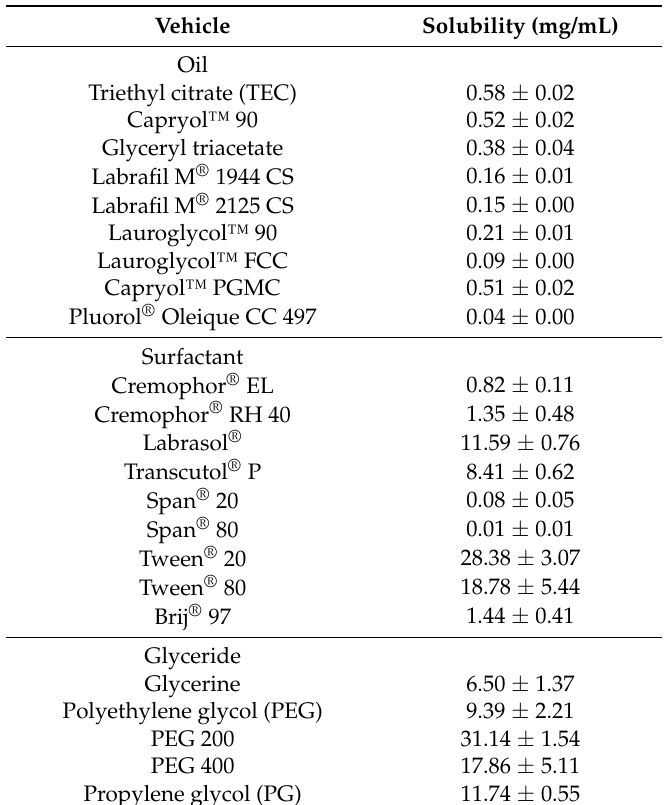
Table 1. The solubilities of raloxifene hydrochloride in various oils and surfactants at 40 ◦ C. All data are means ± SDs ( n =